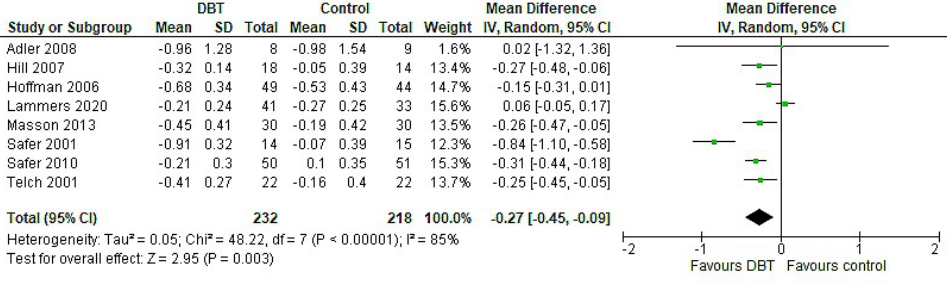
Figure 6. Forest plot: analysis of